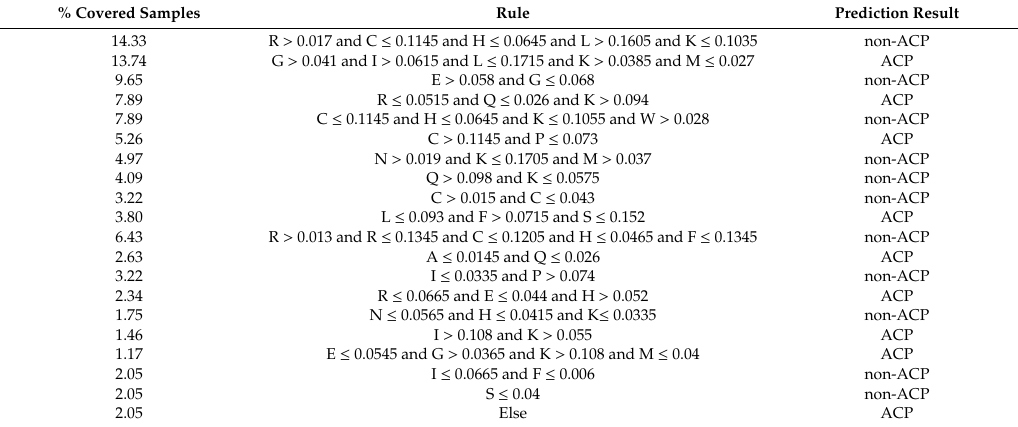
Table A2. Twenty if-then rules for discriminating ACP from non-ACP using random forest and amino acid